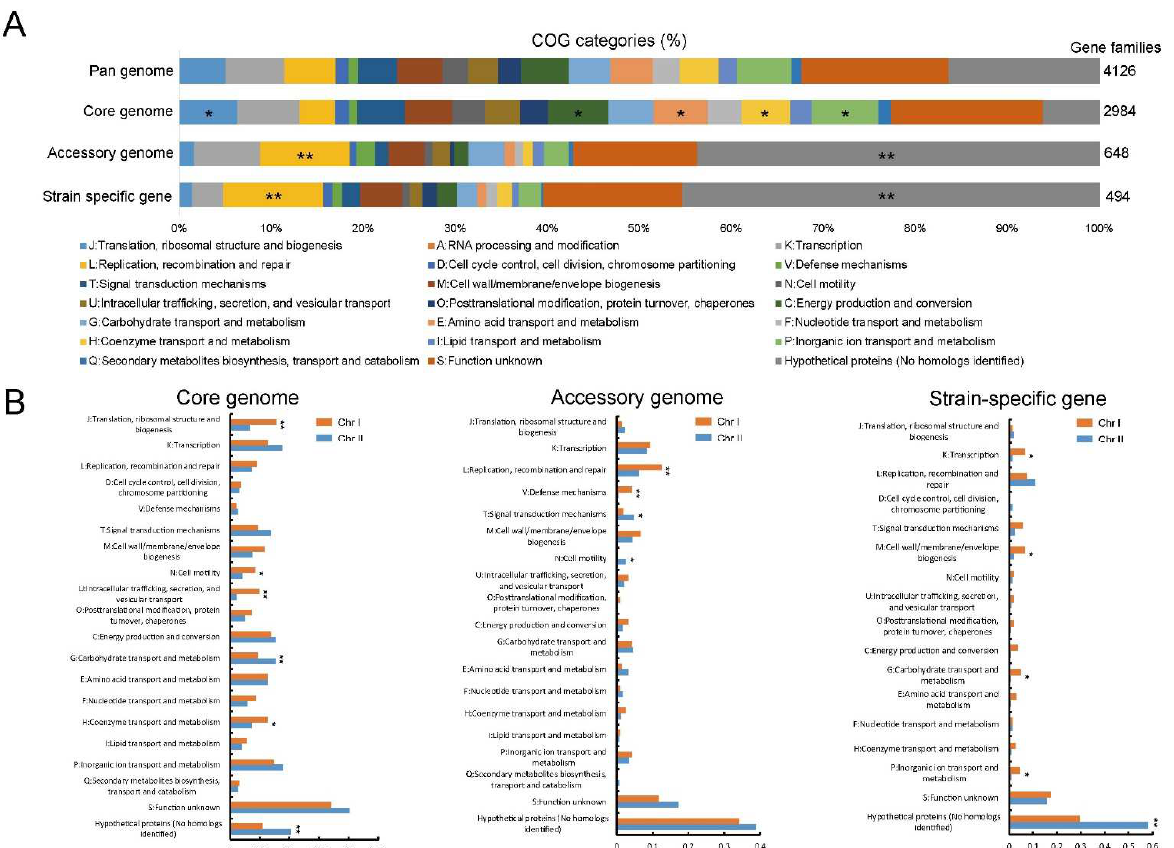
Figure 3. Comparison of functional enrichment for pan-genome. ( A ) Distribution of clusters of orthologous groups (COG) functional categories for pan-genome, core genome, accessory genome, and strain-specific genes, respectively. *: Fisher’s exact test p -value < 0.05; **: Fisher’s exact test p -value < 0.01; ( B ) comparison of COG functional categories for pan-genome, core genome, accessory genome, and strain-specific genes between Chr I and Chr II, respectively. *: t -test p -value < 0.05; **: t -test p -value < 0.01.